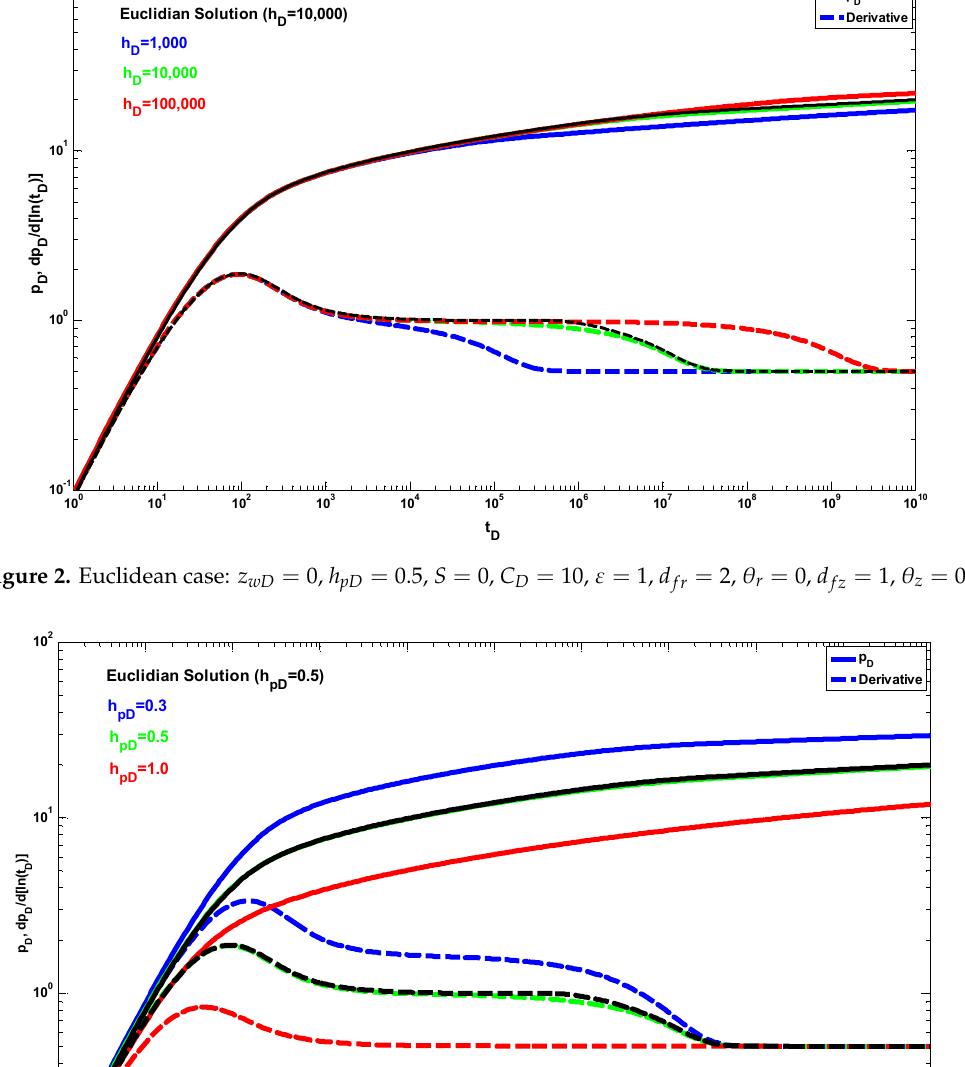
Figure 4. Euclidean case: 𝑧 (cid:3050)(cid:3005) = 0 , ℎ (cid:3005) = 10,000 , ℎ (cid:3043)(cid:3005) = 0.3 , 𝐶 (cid:3005) = 10 , 𝜀 = 1 , 𝑑 (cid:3033)(cid:3045) = 2 , 𝜃 (cid:3045) = 0 , 𝑑 (cid:3033)(cid:3053) = 1 , 𝜃 (cid:3053) = 0 .